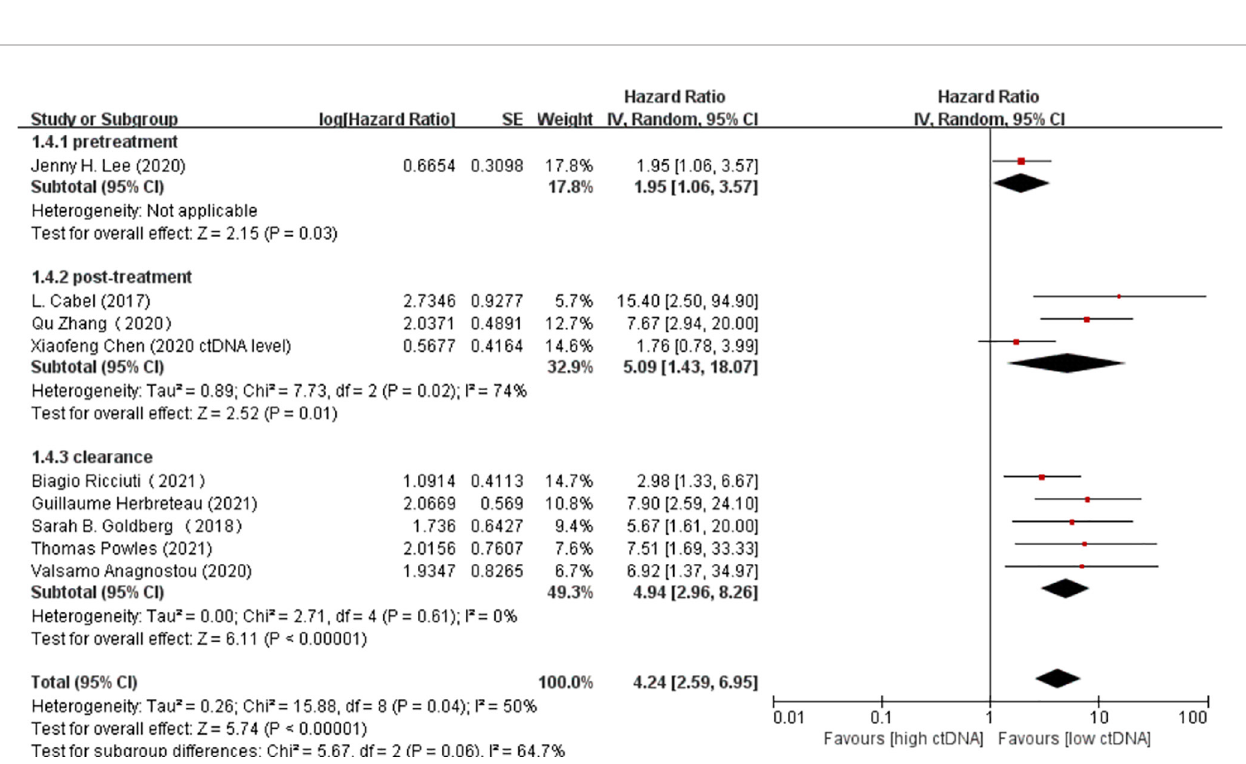
FIGURE 5 | Forest plot of the random effects meta-analysis on the ef fi cacy of circulating DNA (ctDNA) for overall survival (OS) at different time